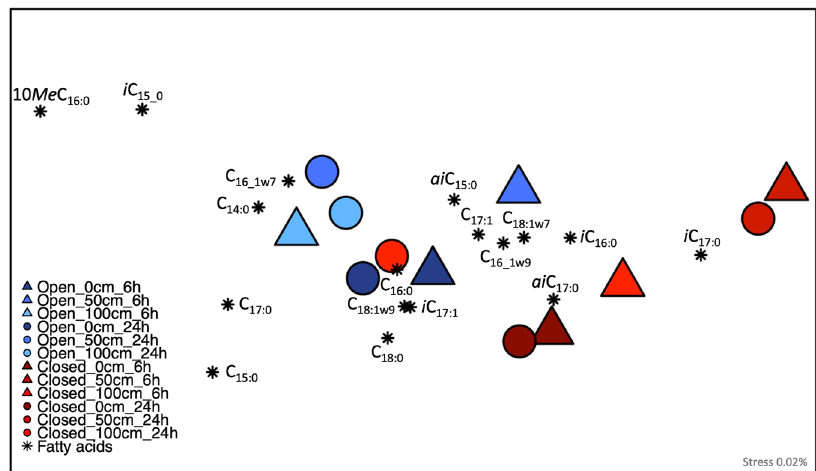
Fig. 3 Nonmetric multidimensional scaling analysis based on the uptake of label into fatty acids. Nonmetric multidimensional scaling analysis (Bray – Curtis dissimilarity) based on the uptake of 13 C-labeled bicarbonate into different fatty acids in the sediment surface (0 – 3 cm) samples. Samples are shown with circles and triangles, while the different fatty acids are depicted with a star symbol. Samples from open incubations (6 and 24 h) are shown in red, while closed incubation samples (6 and 24 h) are colored in blue. 0, 50, and 100 denotes distance along the transect in